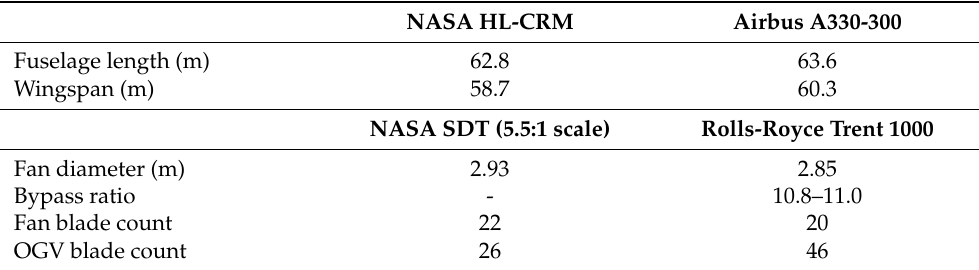
Figure 1. The NASA HL-CRM/SDT configuration in the present study. The lower part of the figure shows a comparison between the baseline configuration and others equipped with poro-serrated OGVs. LE serrations in the M450E inset are colored red and green to distinguish the solid region from the porous one. Table 1. Comparisons between the NASA-CRM/SDT geometries against some real-life examples.